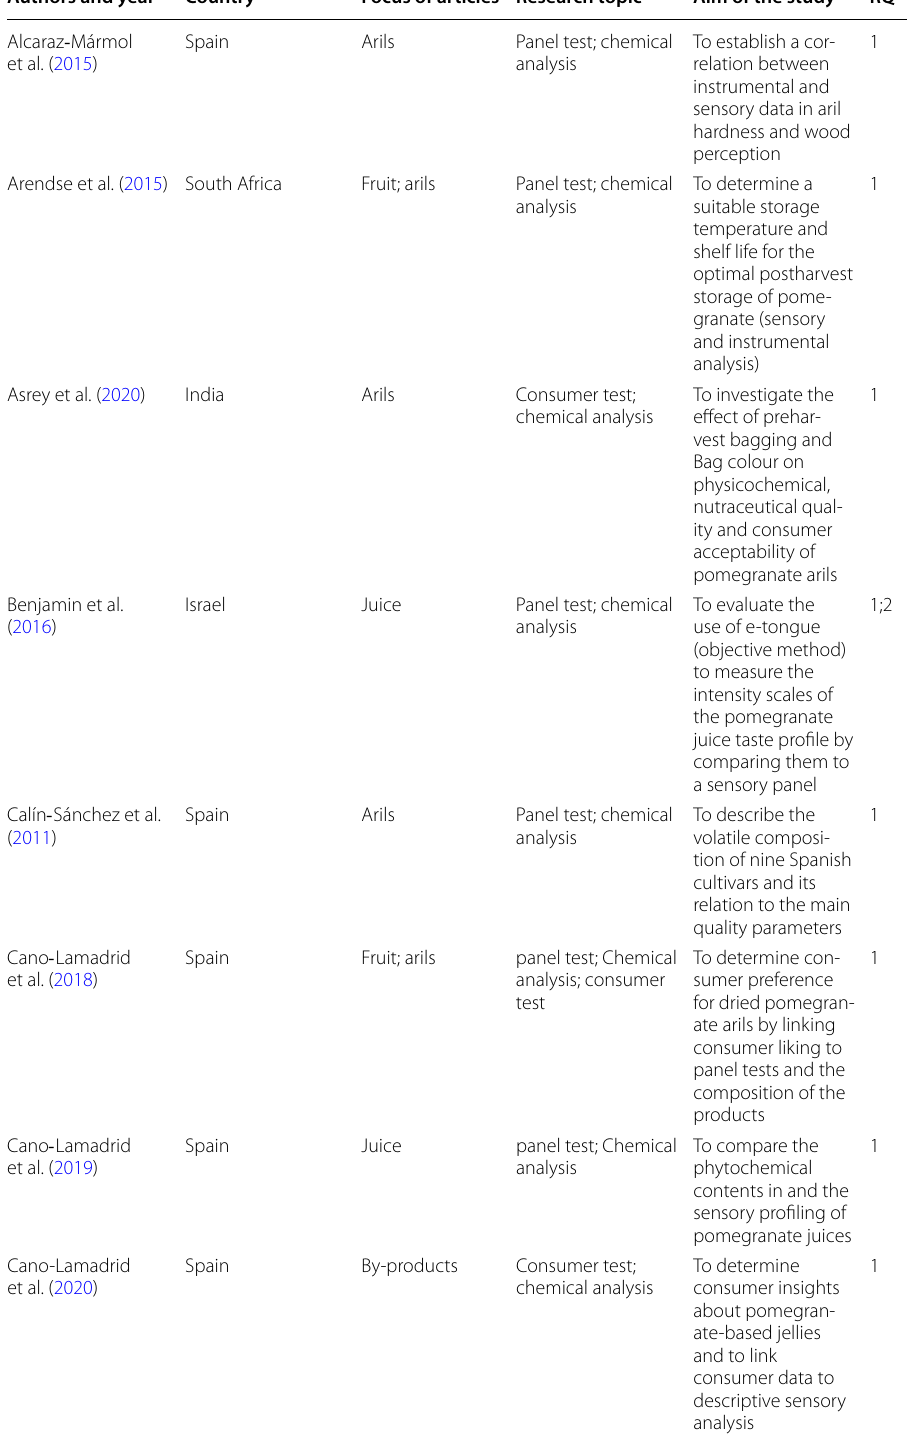
Table 2 List of included studies with details on country, products investigated, research topic, aim and research question (RQ)